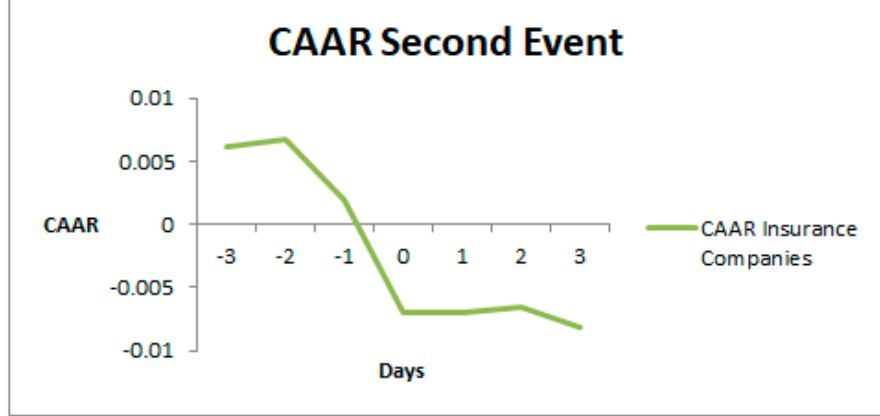
Figure A4. CAARs for insurance companies associated with the first event. Source: Authors’ work.